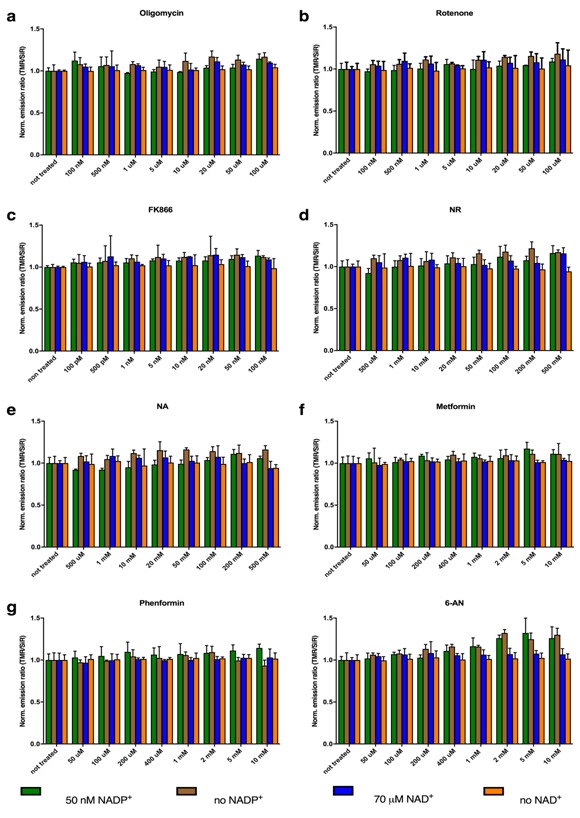
In vitro titration to assess potential interference of the investigated compounds on the sensor’s performance.NAD(P)-Snifits were incubated with different concentrations of the compounds in the presence of the respective cofactor. Cofactor concentrations were set around the c50 as perturbations on the sensor’s performance should be most prominent in this range. The same experiments were performed in the absence of the cofactor to exclude that the sensors can be closed by the compounds. No significant perturbation of the sensor’s performance was observed. (a) Oligomycin, (b) Rotenone, (c) FK866: (E)-N-[4-(1-benzoylpiperidin-4-yl)butyl]−3-(pyridine-3-yl)acrylamide, (d) NR: nicotinamide riboside, (e) NA: nicotinic acid, (f) Metformin, (g) Phenformin, (h) 6-AN. Three independent experiments were measured and the mean values including ± s.d. are shown.